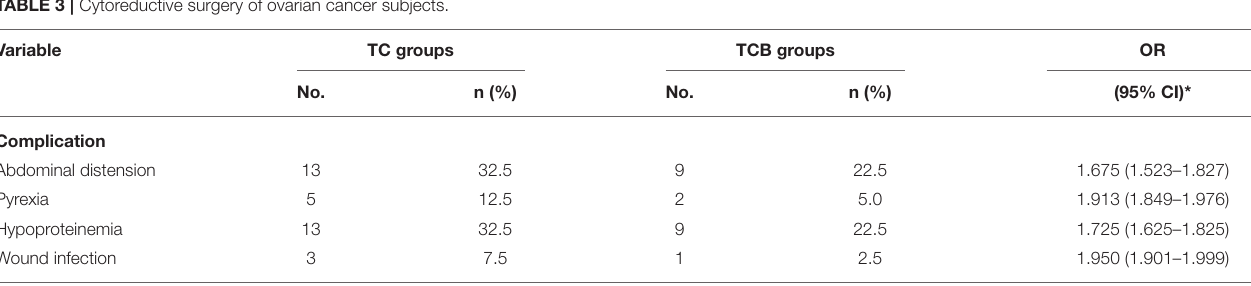
TABLE 3 | Cytoreductive surgery of ovarian cancer subjects.